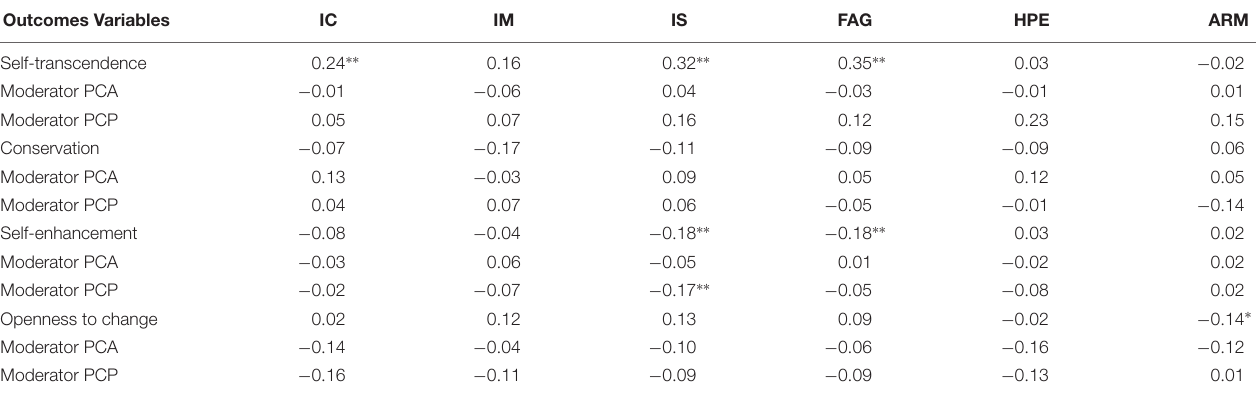
TABLE 6 | Results testing the moderation effects of perceived club autonomy and perceived club pressure in the relationship between value dimensions and transformational leadership behaviors ( N = 266 coaches). Outcomes Variables IC IM IS FAG ARM Self-transcendence